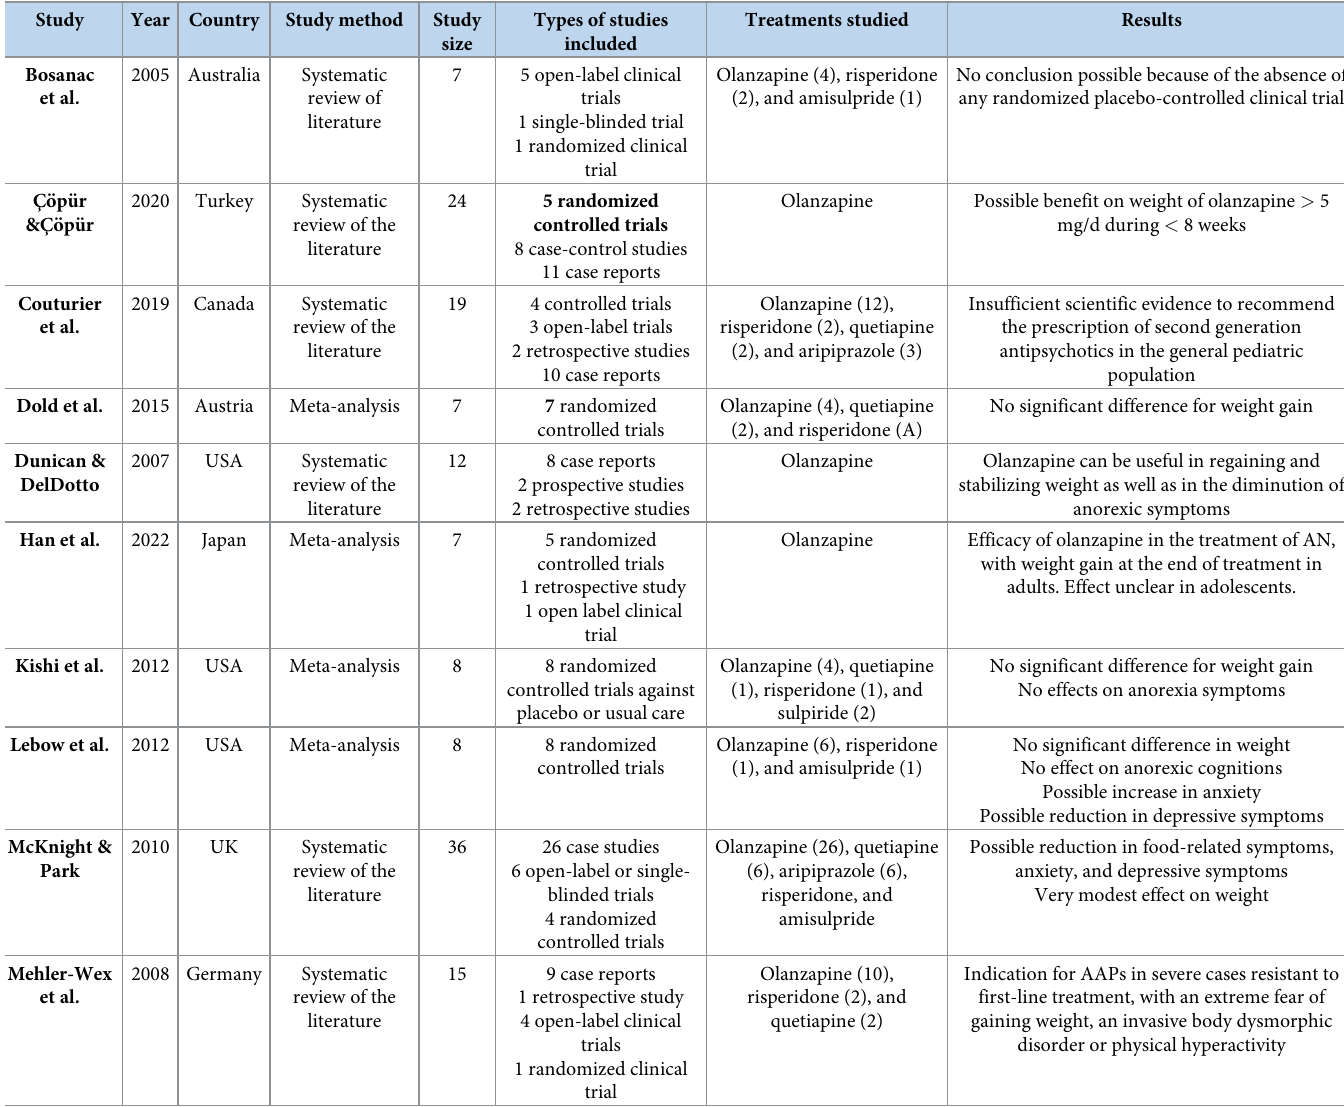
Table 3. Literature reviews and meta-analyses of atypical antipsychotic drugs in AN included in the scoping